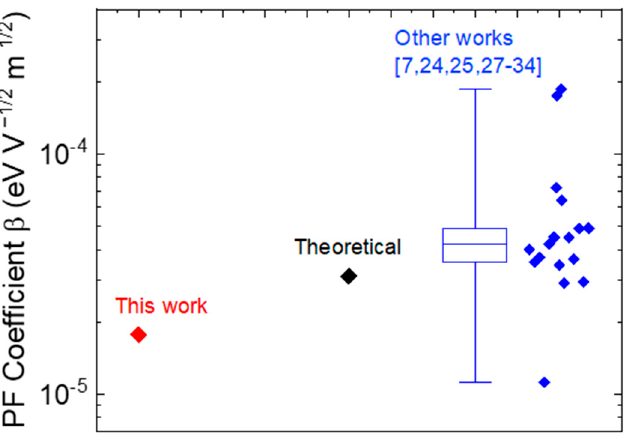
Figure 5. Comparison of the Poole–Frenkel coefficient ( β ) ≈ 10 − 5 eV V − 1/2 m 1/2 obtained from different works on GaN-based systems [7,24,25,27–34].